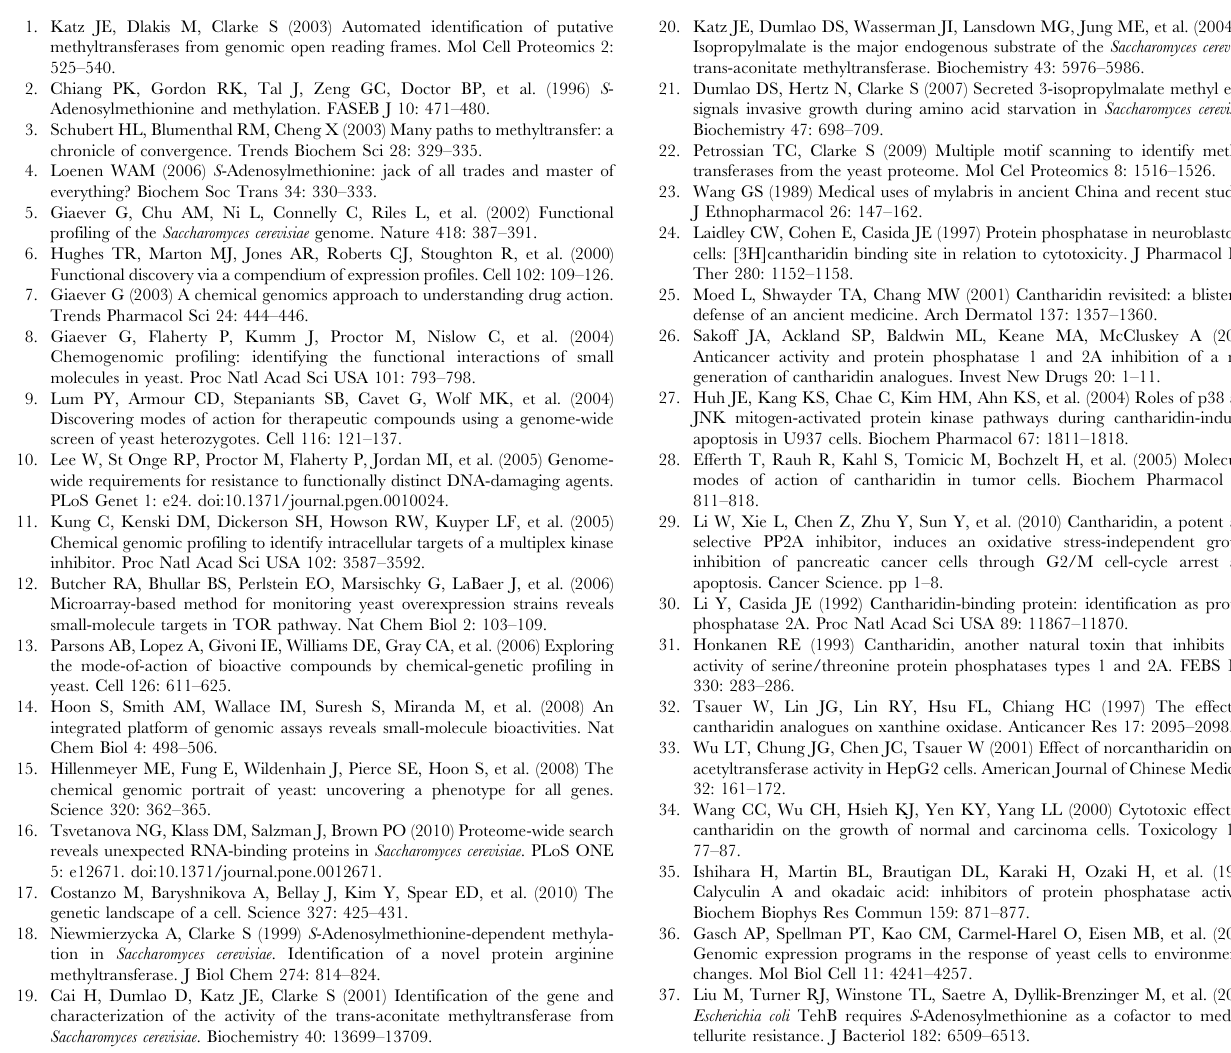
Table S7 Primers used in this study. Text S1 Supporting Materials and